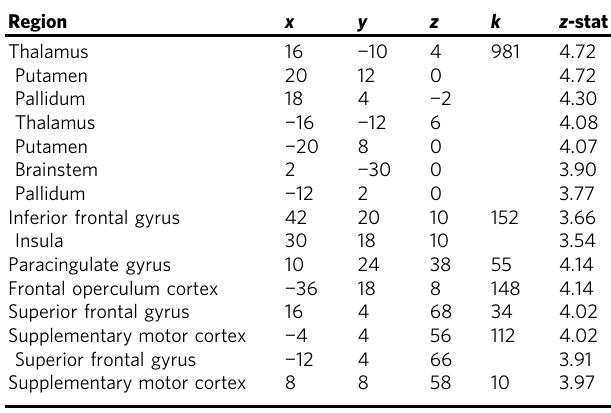
Table 3 for descriptive performance data and Supplementary Fig. 2 for individual data points.